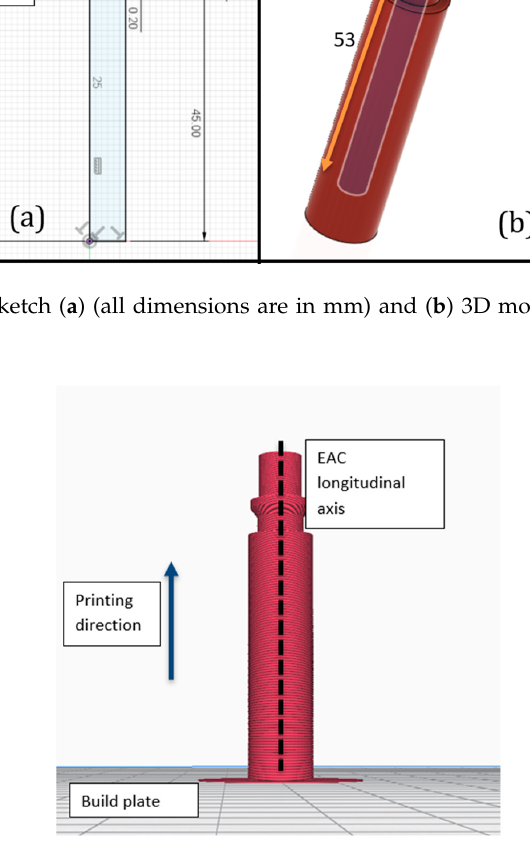
Figure 3. Printing